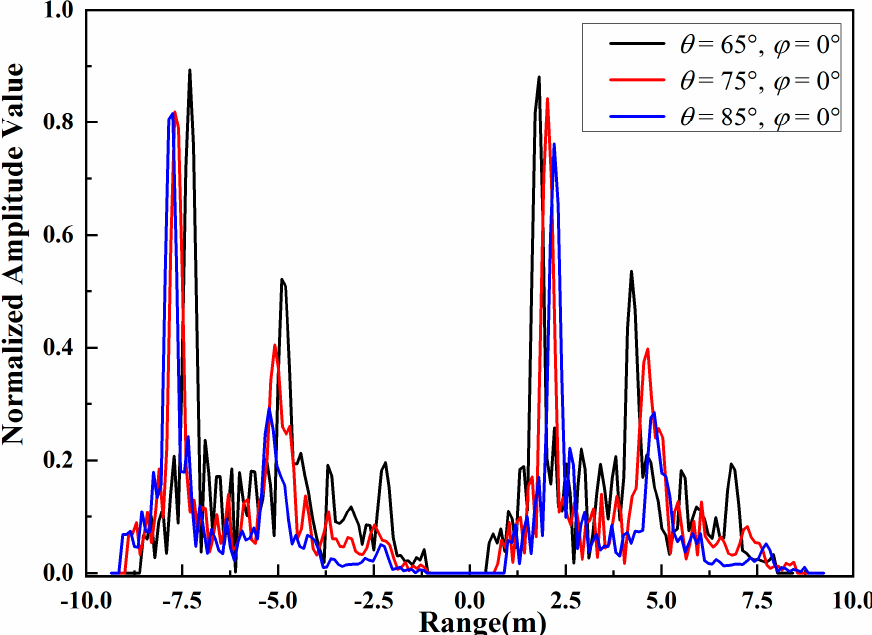
Figure 12. The HRRP of hybrid dielectric and conductor missile-like targets with different pitch angles in the free space.